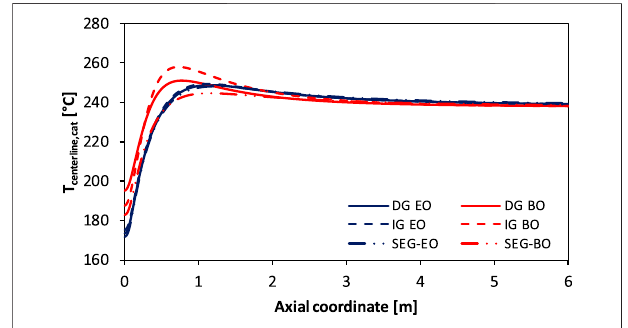
FIGURE 4 | Catalyst centerline temperature axial pro fi